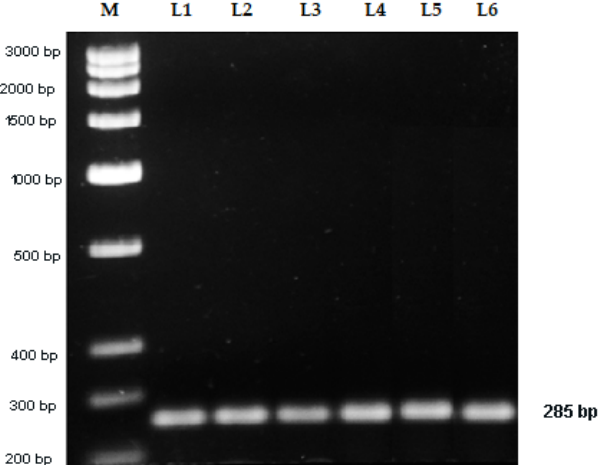
Figure 5. Amplification of accessions of Viola serpens using SCAR primers (Vio F and Vio R). Lane M = DNA marker, Lane L1–L6 = Samples of Viola serpens. Table 5. Sequence of SCAR primers, PCR condition, and product